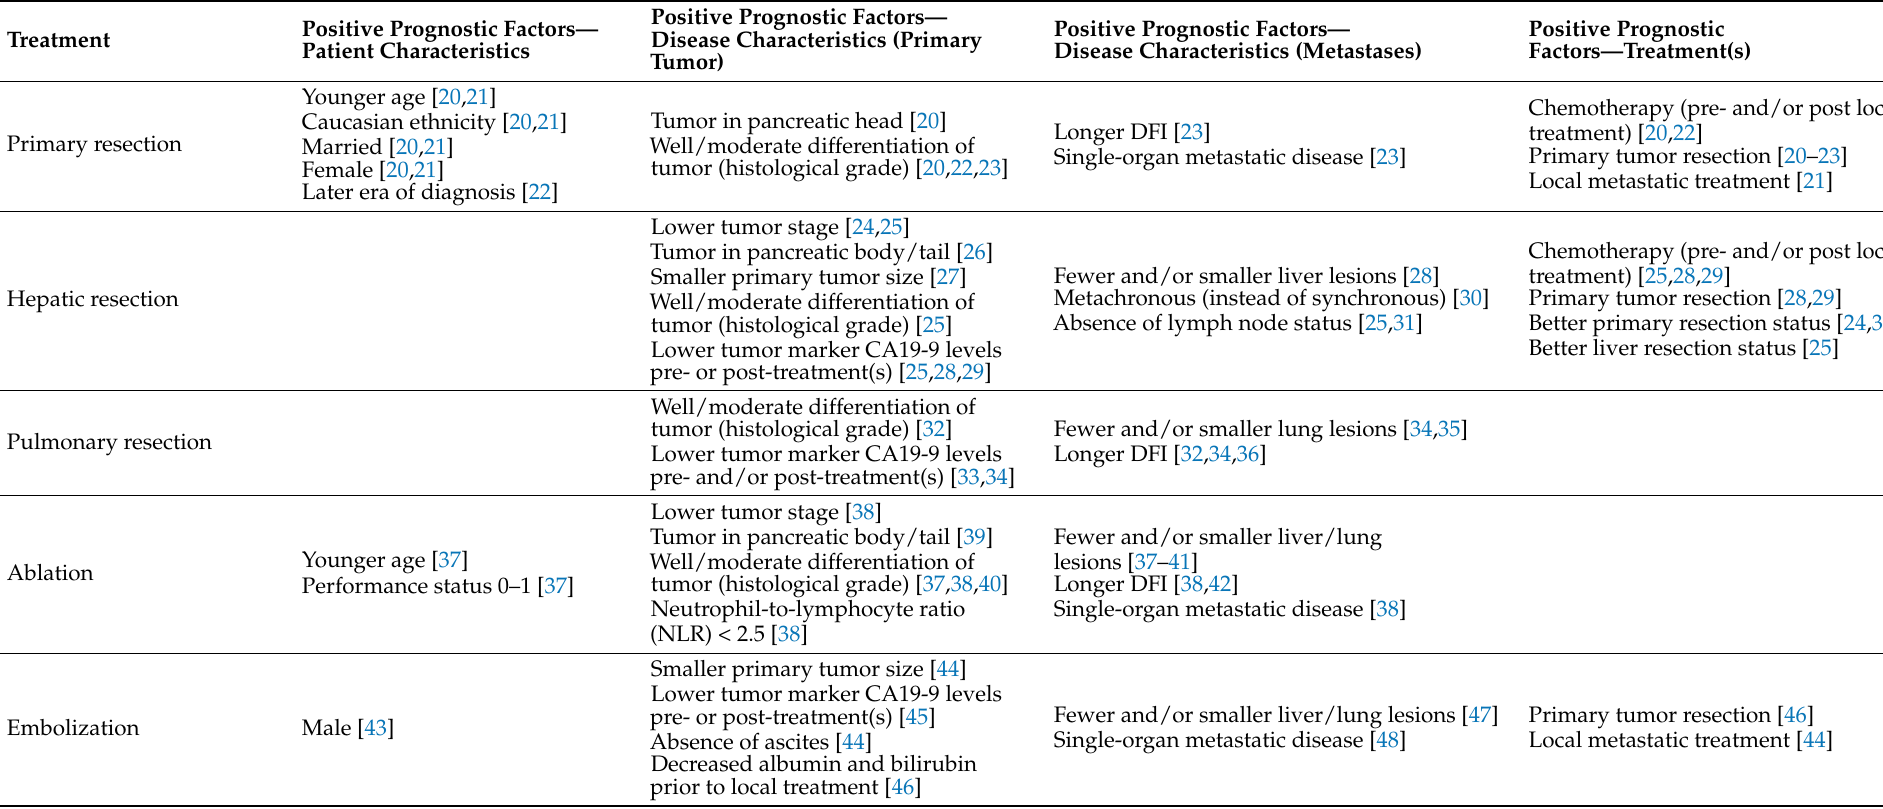
Table 2. An overview of positive prognostic factors per article category (primary resection, hepatic resection, pulmonary resection, ablation and